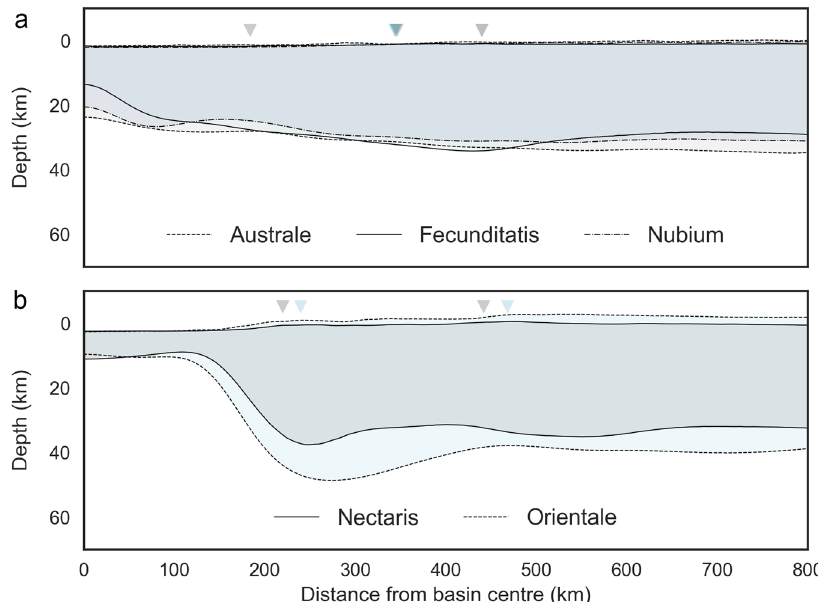
Fig. 1 Topographic and crustal thickness pro fi les for lunar basins. a Azimuthally averaged pro fi les of the surface relief and crust-mantle interface (derived from GRAIL gravity data 33 ) for the pre-Nectarian impact basins Australe (dashed line), Nubium (dash-dot line), and Fecunditatis (solid line) compared to the likely similar sized, but younger, Nectaris (solid line) and Orientale (dashed line) basins b . Arrows denote previously mapped main and/or peak (inner) rim (observed or suspected) 24 . See, Supplementary Table 1 for